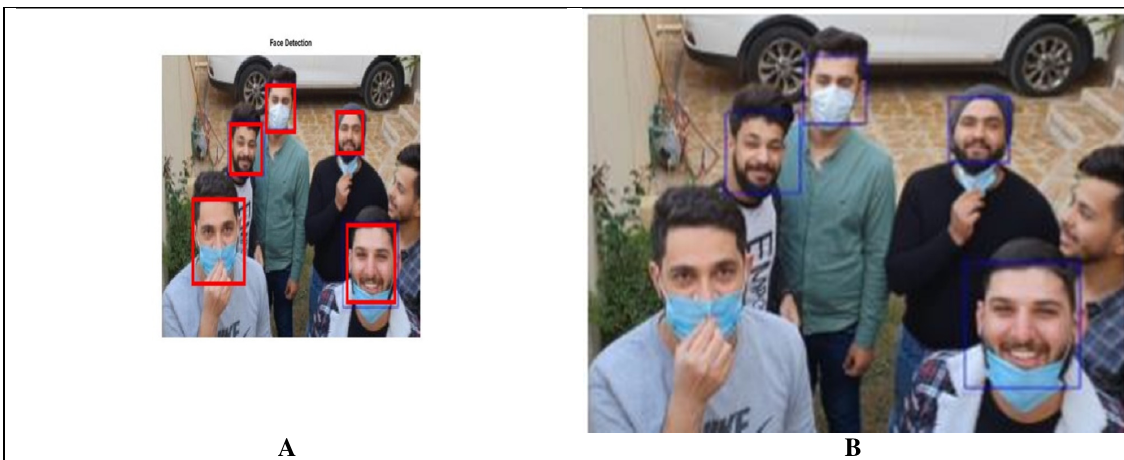
Fig. 7. Face detection with wearing masks A. Results from our system. B. Results from researchers